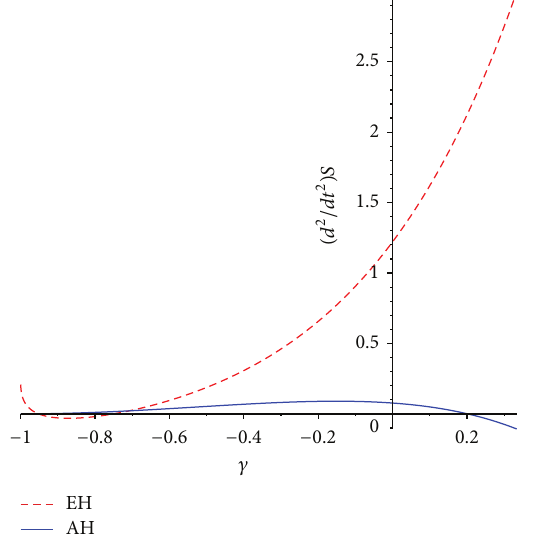
Figure 8: TE for DGP brane for Modified Chaplygin